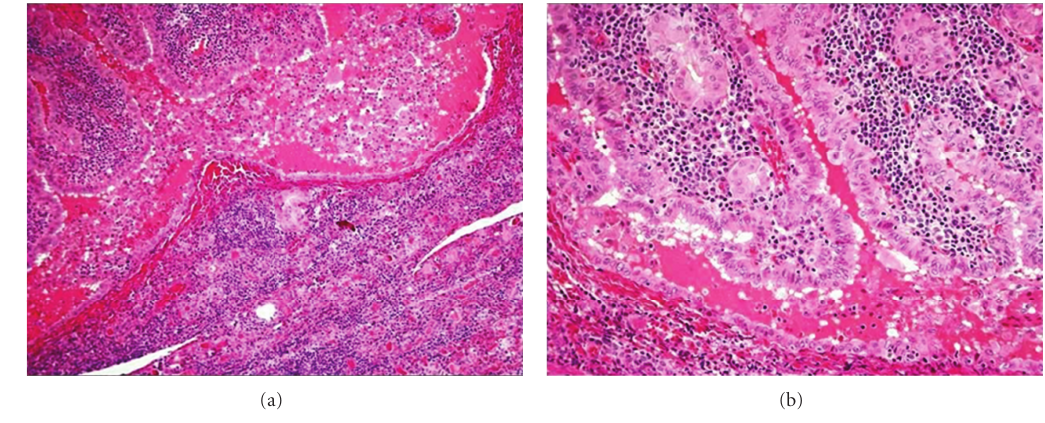
Figure 1: Hematoxilin and Eosin, stained sections of the